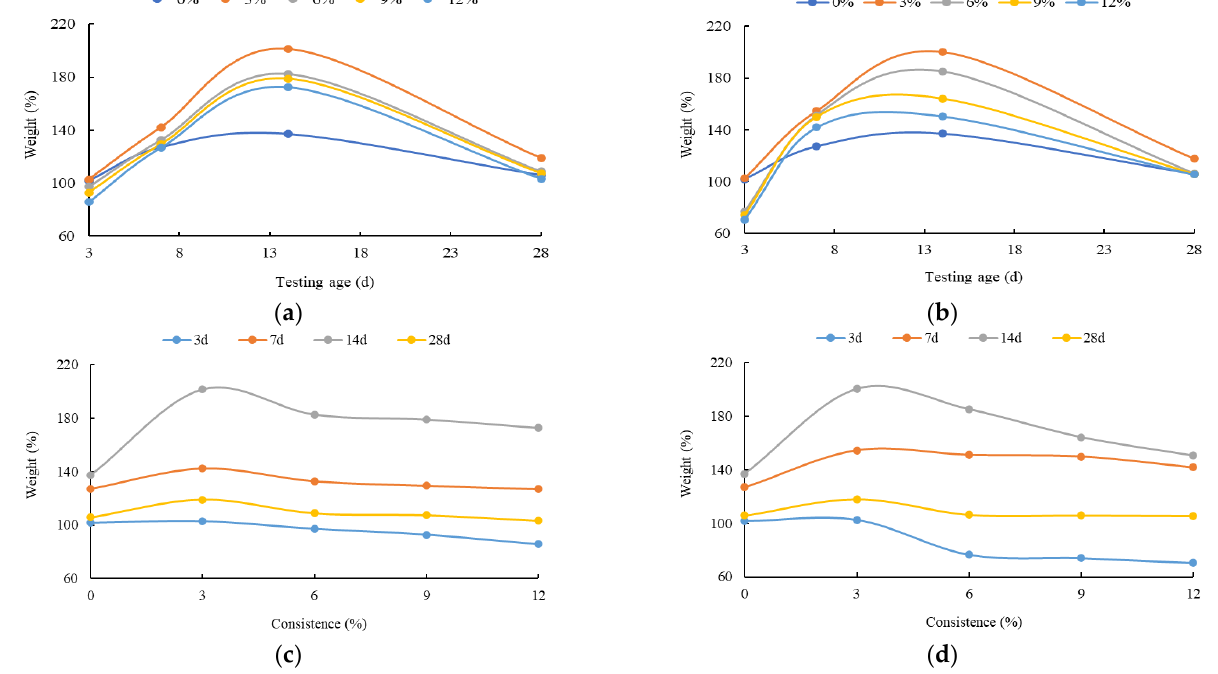
Figure 9. Changes in the peak area of hydration products in the first stage of endothermic peak: ( a ) IN; ( b ) OU; ( c ) IN; ( d ) OU.